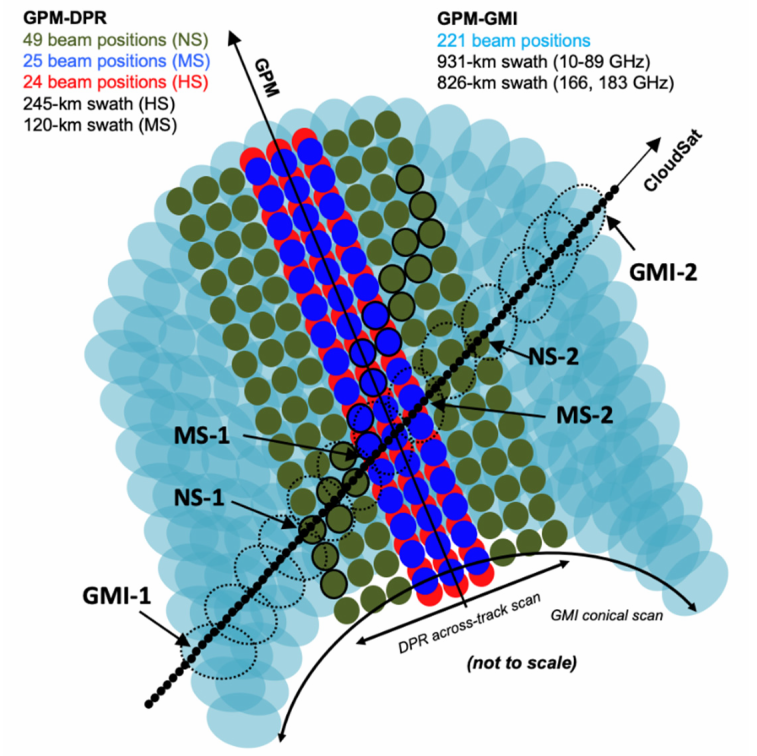
Figure 1. Illustration of GPM–GMI, GPM–DPR and CloudSat radar viewing geometry. Adapted from Figure 1 in Ref. [22]. See text for